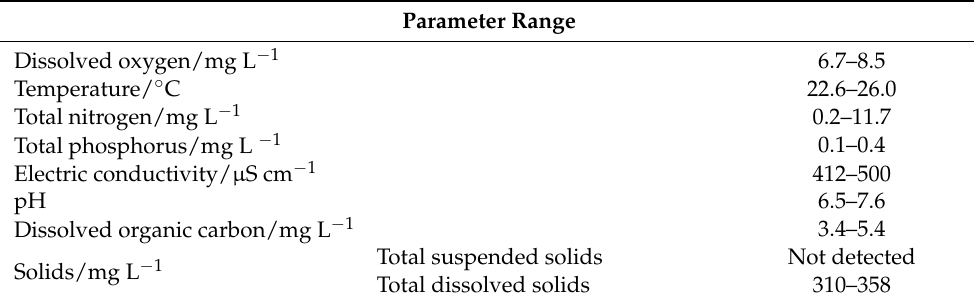
Table 2. Characteristics of MBR-treated